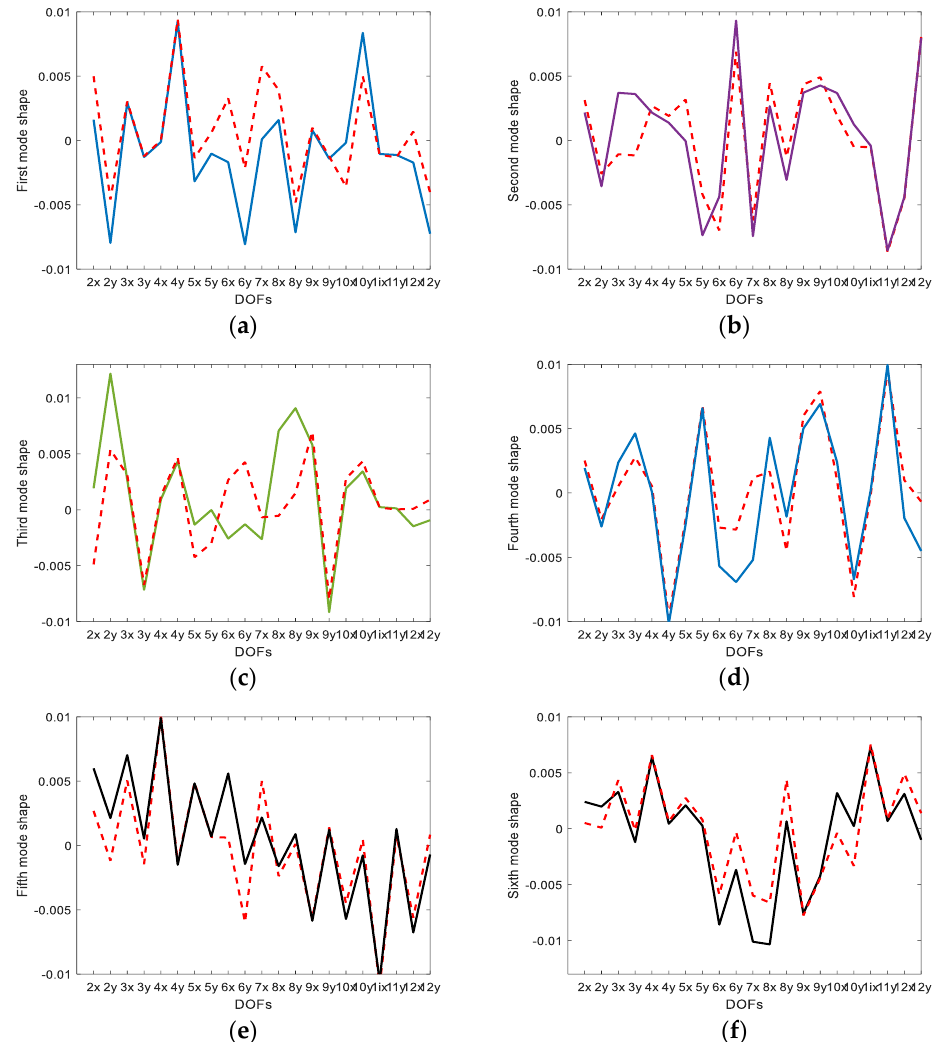
Figure 10. Comparison of estimated and actual mode shapes (strain mode shape-based approach): ( a ) first mode; ( b ) second mode; ( c ) third mode; ( d ) fourth mode; ( e ) fifth mode; ( f ) sixth mode. The solid line indicates the actual mode shape and the dotted line is the estimated mode shape.